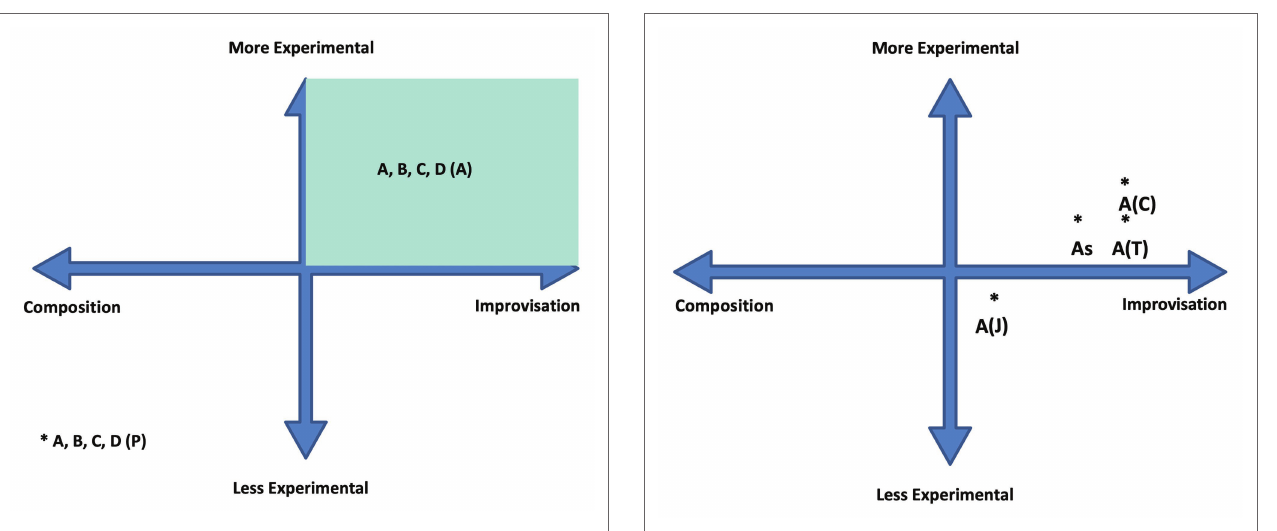
FIGURE 7 | ECIC relationships in Coltrane’s solo on “My Favorite Things.” The asterisk indicates the position on the ECIC of the individual performers in Section A of the performance of “My Favorite Things,” as referred to in the text.